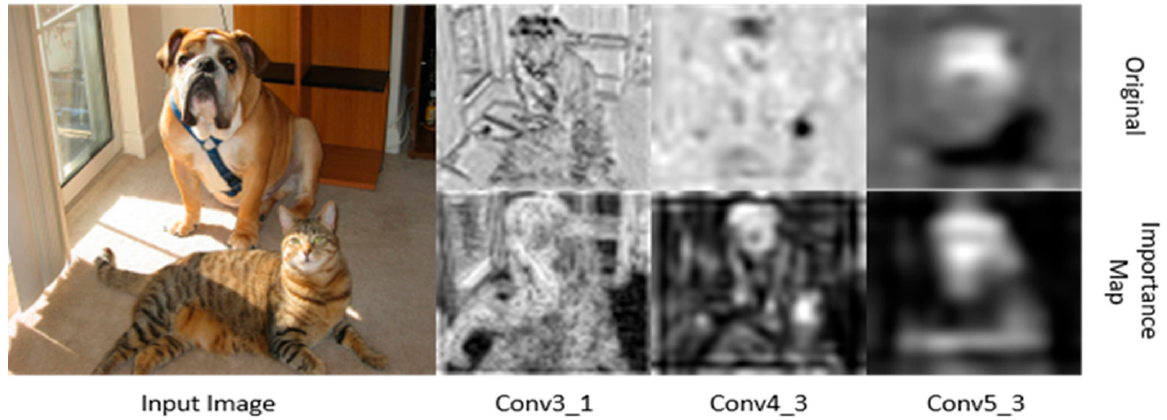
Figure 3. Original feature map and importance map at each visual geometry group-16 (VGG-16) layer. At the shallow layers, the feature map includes global features, whereas class-specific fea-tures are included at the deep layers. The importance map activates more regions with objects. We visualize that a pixel value close to 0 is black, and close to 1 is white. Please note that the self-attention map has a similar distribution to the importance map. Thus, we do not show